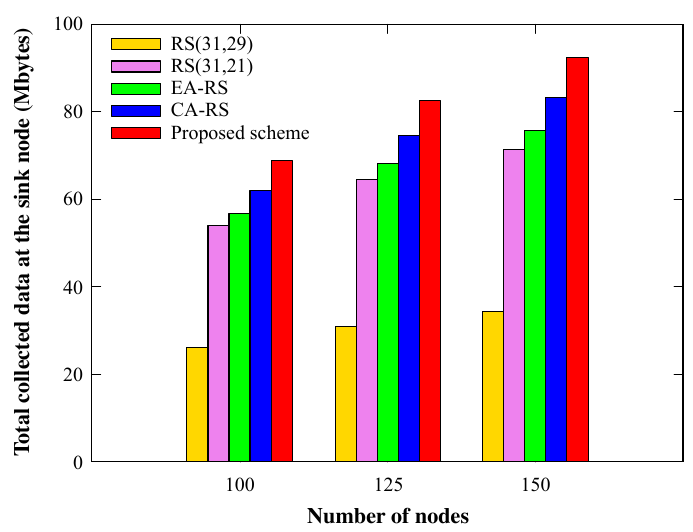
Figure 13. Total amount of received data at the sink node with various node counts (BER 0.15).